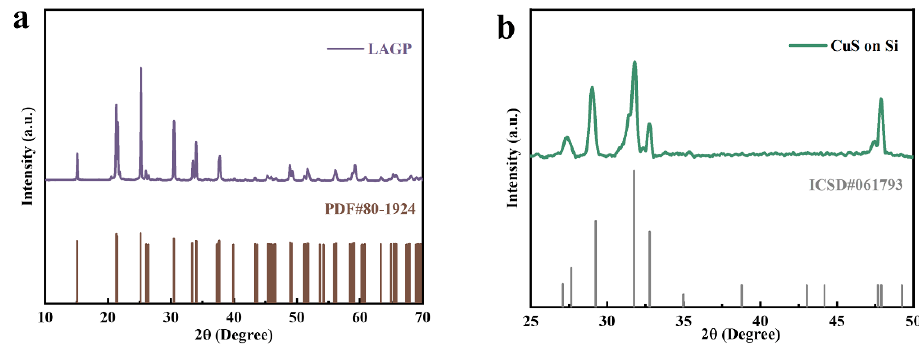
Figure 3. XRD patterns of the ( a ) LAGP pellet and ( b ) CuS film deposited on the Si plate.